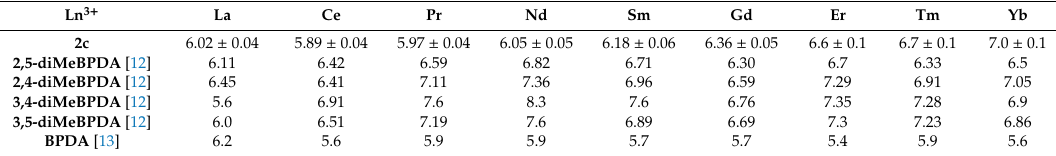
Table 4. Log β 1 values for the stability of trivalent lanthanides ions with 2c ligand in acetonitrile. Ln 3 +